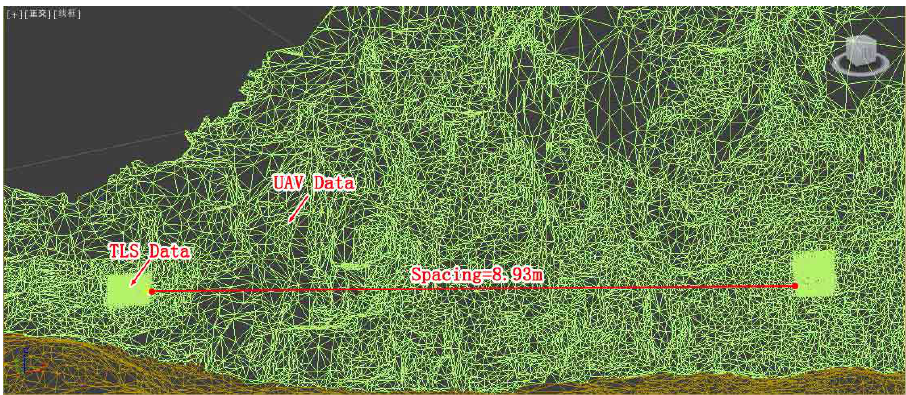
Figure 8. Space between the No. 3 and No. 4 holes on the Chiya Plank Road in 3Ds